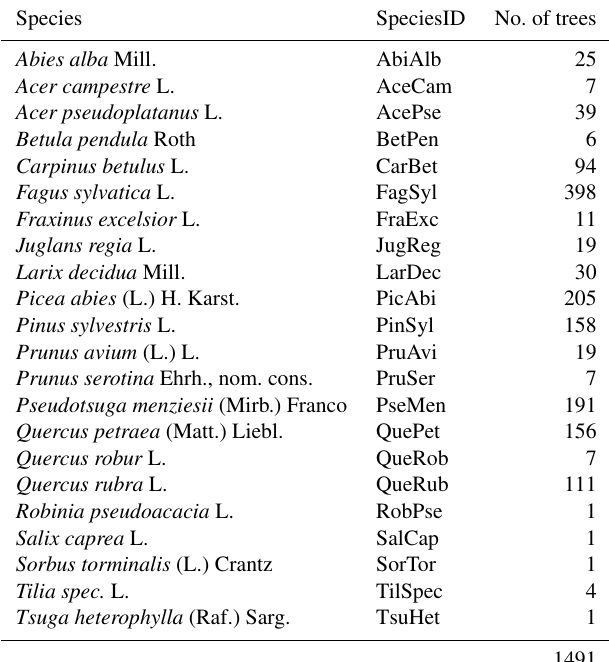
Table 4. Number of trees of each species in the dataset. Species SpeciesID No. of trees Abies alba Mill. AbiAlb